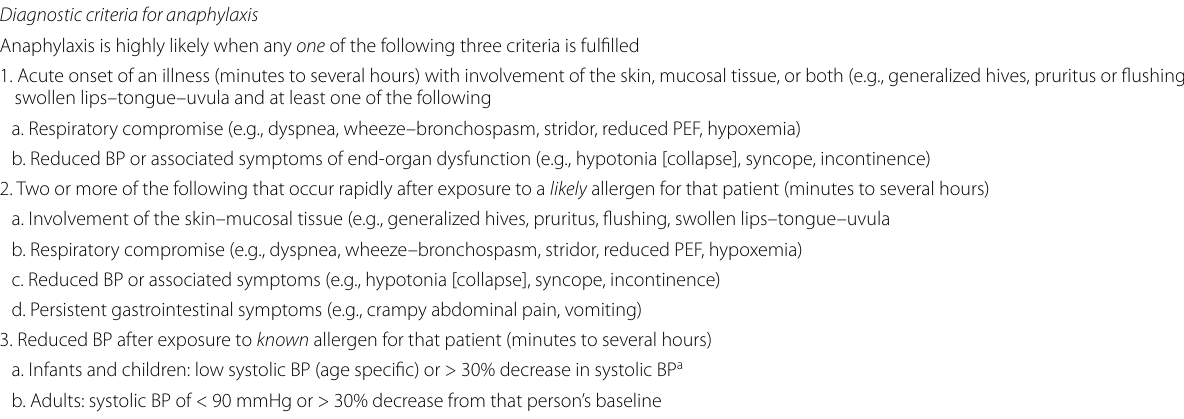
PEF peak expiratory flow, BP blood pressure a